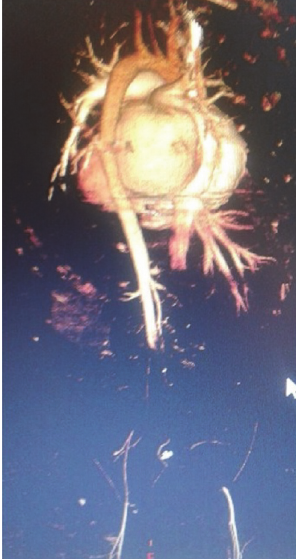
Figure 1: Abdominal computed tomography with contrast demon- strated a large occlusive thrombus within the infrarenal aorta, thrombus in bilateral iliac artery, and focal hypodense areas in the left external right kidney